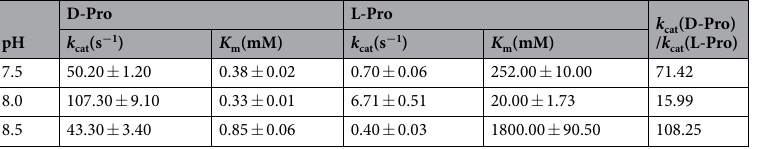
Table 2. Comparison of kinetic parameters of DAAO to D-Pro and L-Pro under different pH values.